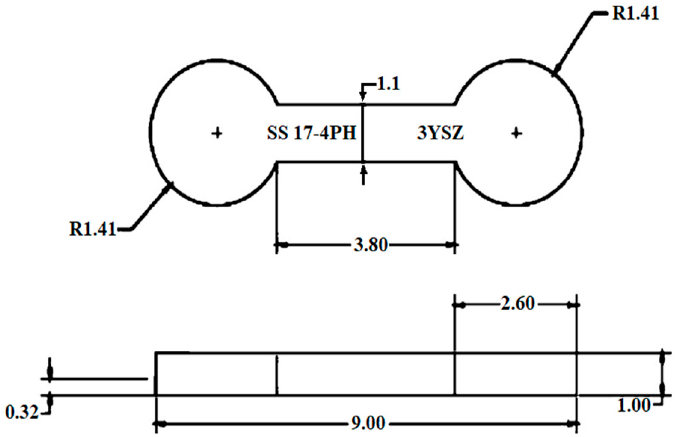
Figure 3. Dimensions of the bi-material micro-part of SS 17-4PH and 3YSZ.